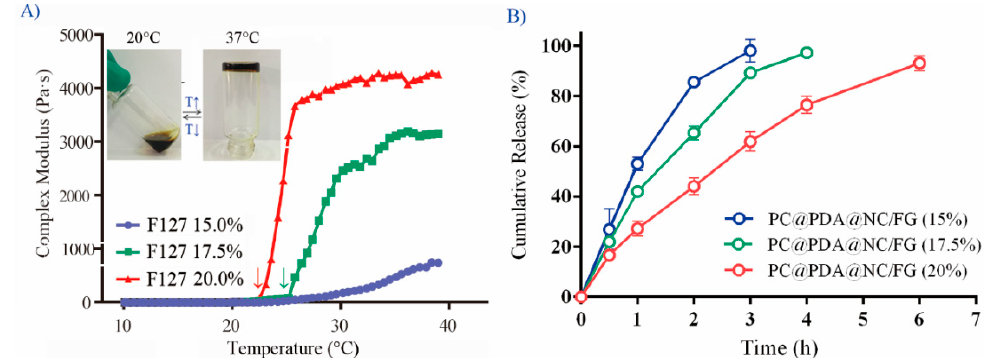
Figure 4. Rheological and in vitro release profiles of NC@PDA-NH 2 /FG. ( A ) Temperature-dependent rheological profiles of NC@PDA-NH 2 /FG with different F127 concentration (15.0%, 17.5%, and 20.0%, w / w ). The red and green arrows denote the gelation temperature for 20.0% and 17.5%, respectively, while the thermal phase transition was not obvious for 15.0%. The insert is the typical photograph of NC@PDA-NH 2 /FG (17.5%) at storage (20 ◦ C) or body temperature (37 ◦ C). ( B ) Release profiles from